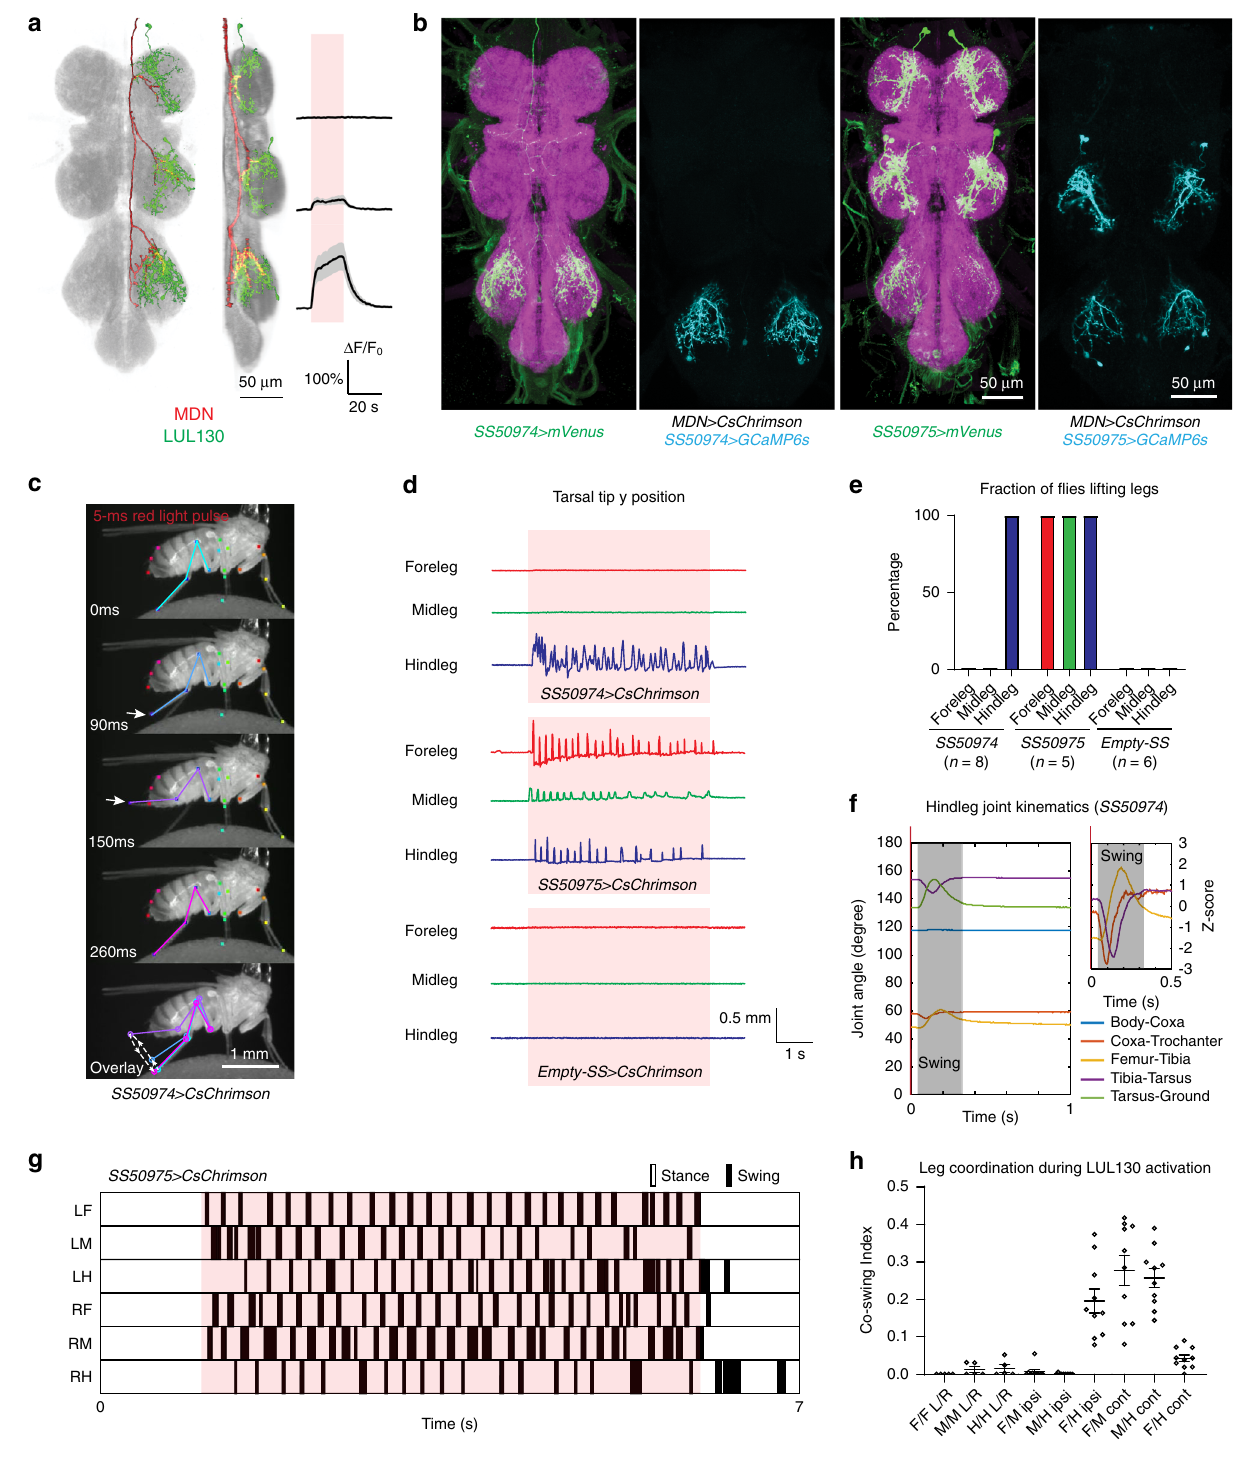
(Fig. 7c and Supplementary Movie 6). In contrast, when LUL130 neurons were silenced, the power stroke was unaffected, as judged by the initial speed of tibia fl exion. However, in these LUL130- silenced fl ies, the leg appeared to be stuck in stance phase, with the tibia fl exing to a much greater extent before swing was eventually initiated (Fig. 7c and Supplementary Movie 10). We quanti fi ed these effects by measuring the femur-tibia joint angle during each step in the 10-s blue-light stimulus period of experimental trials and the corresponding periods of control trials